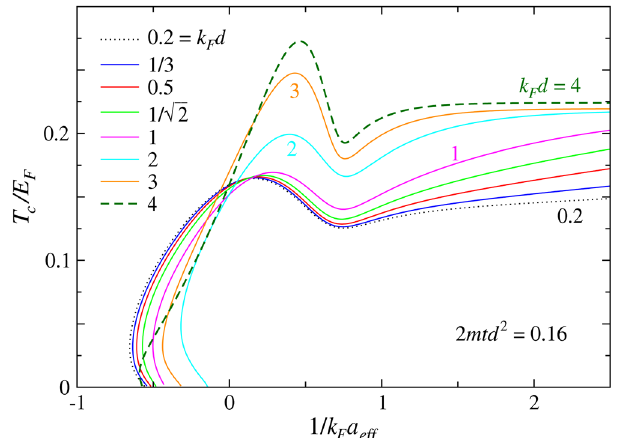
Figure 7. Behavior of T c as a function of k a 1/ for fixed = . mtd 2 0 16 2 . Except for large d , the T c curves are close F in the BCS and crossover regimes, while the discrepancies become more pronounced in the BEC regime. The k F d = 4 case has a good Fermi surface match, exhibiting the least frustration on